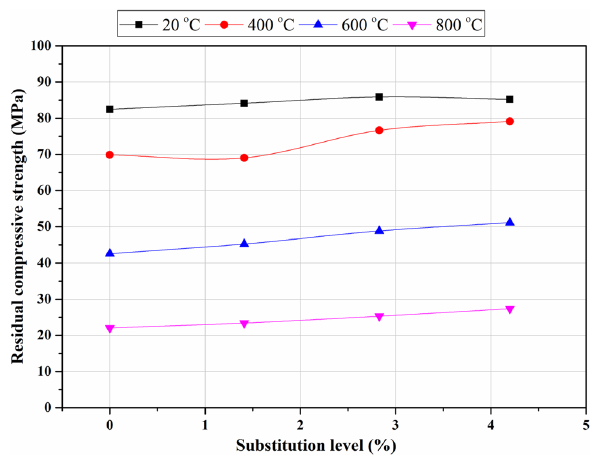
Fig. 6 Variation of 28-day compressive strength of concrete with substitution level of nanoparticles: (1): nano-SiO SiO [25]; (3): nano-clay [25]; (4): nano-SiO 2